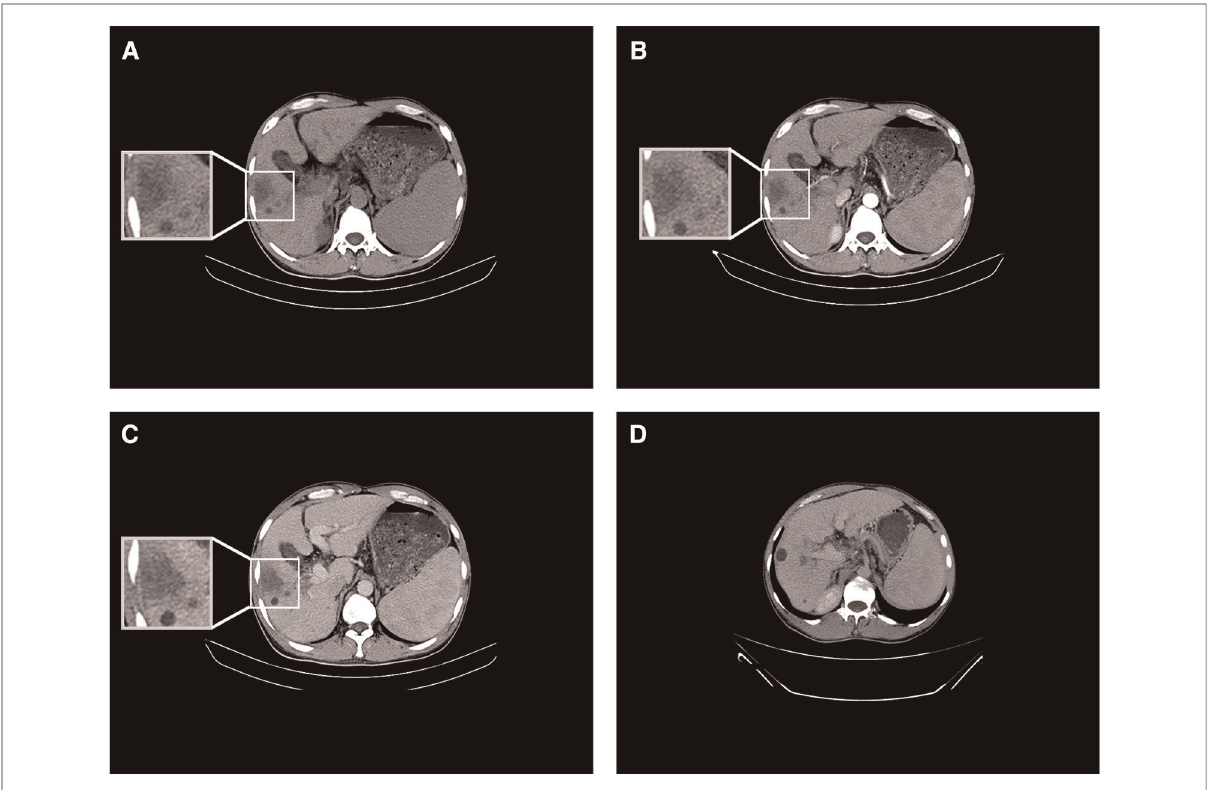
FIGURE 2 Results of CT conducted on 23 July 2019. ( A ) Upper abdominal CT showing a low-density shadow in the right lobe of the liver. ( B ) Enhanced CT showing no enhancement of the shadow in the right lobe of the liver at the artery stage. ( C ) Enhanced CT indicating no enhancement in the shadow in the right lobe of the liver at the vein stage. ( D ) Enhanced CT depicting portal vein tumor thrombus regression at the vein